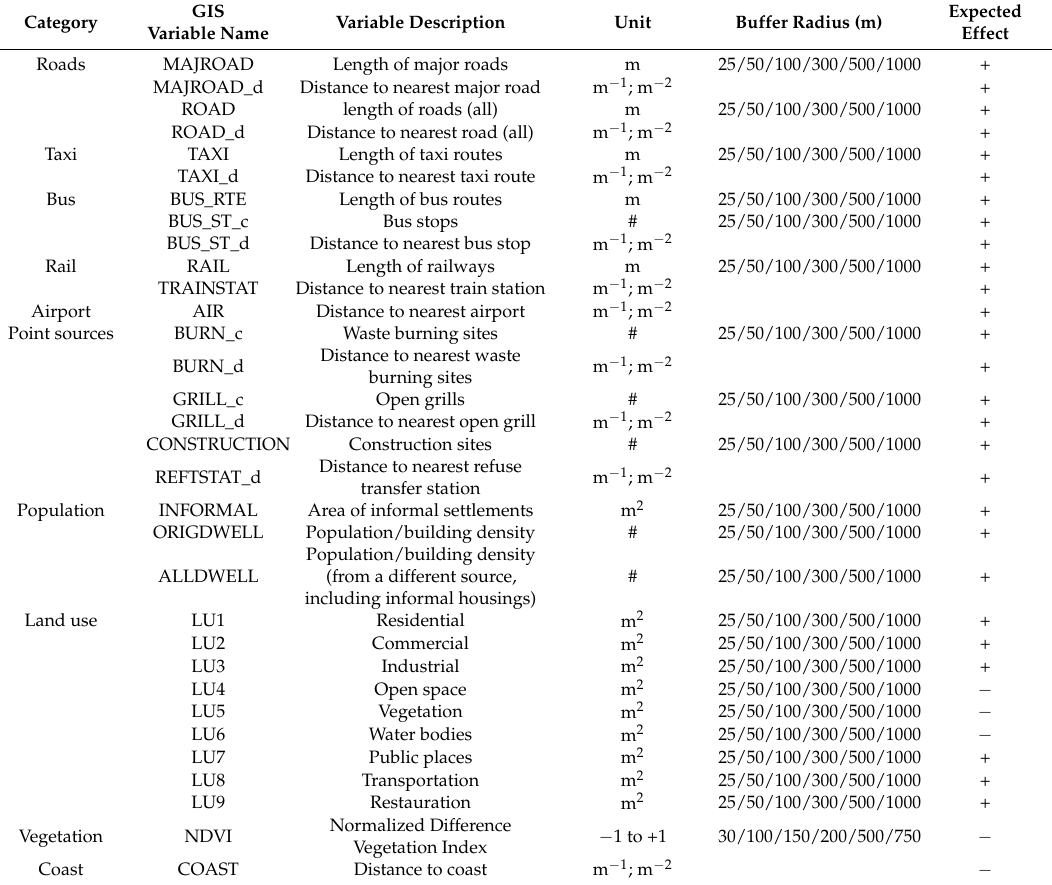
Table 1. List of the main GIS predictors collected and used for predictive land use regression (LUR) models of NO 2 and PM 2.5 concentrations, including buffer size, unit, transformations and expected direction of the